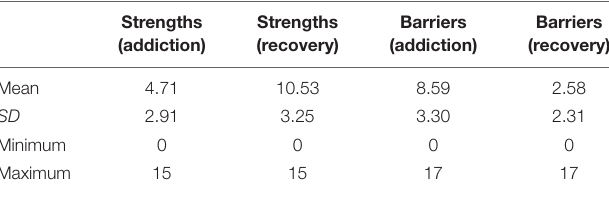
TABLE 2 | Number of strengths and barriers while in addiction and recovery ( n = 1,313). Strengths Strengths Barriers (addiction) (recovery) (addiction)